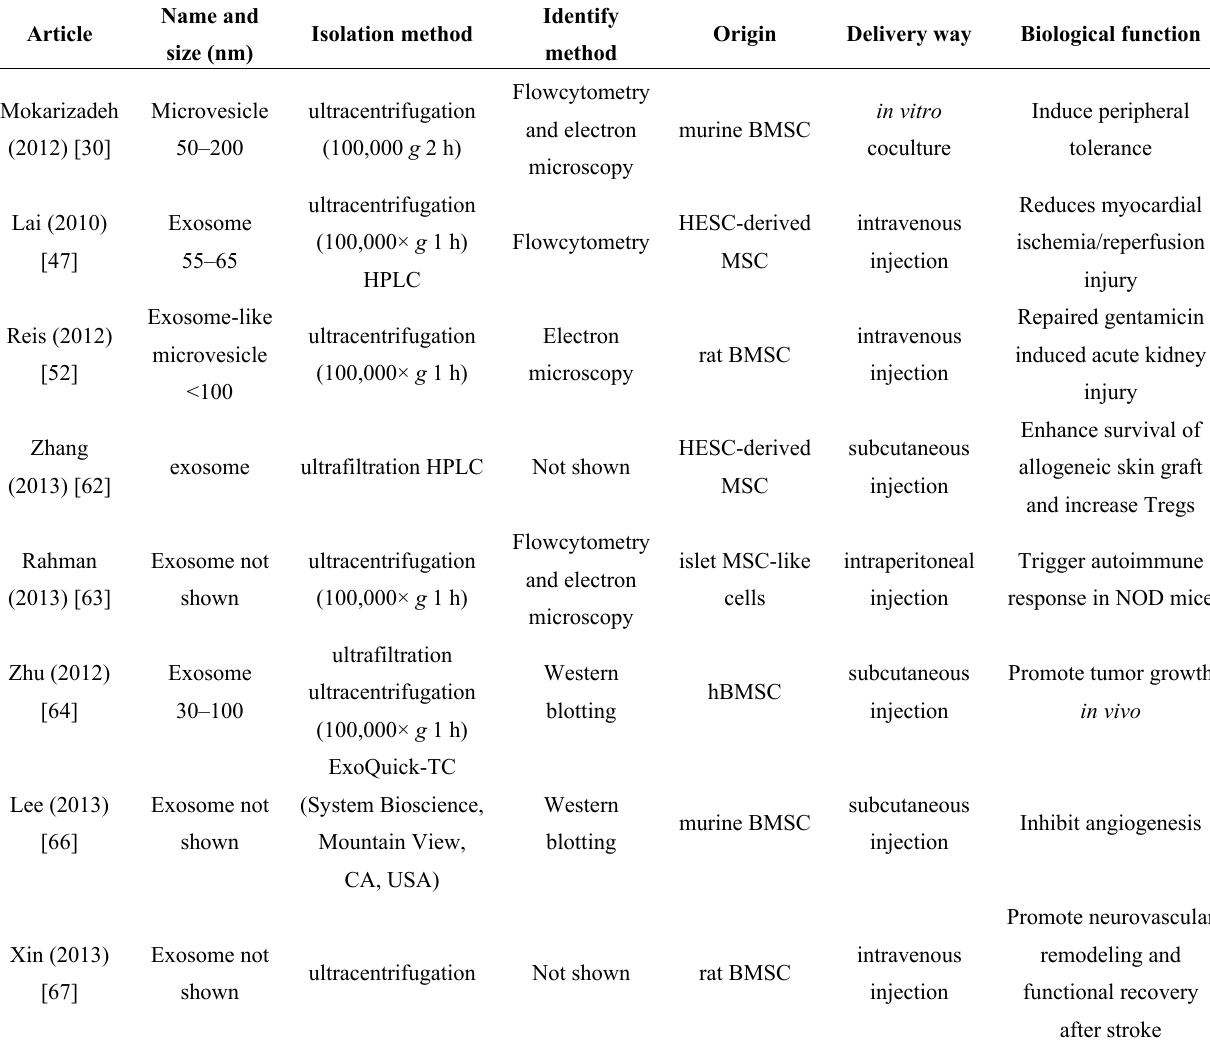
Table 1. Information of MSC-derived exosomes in different